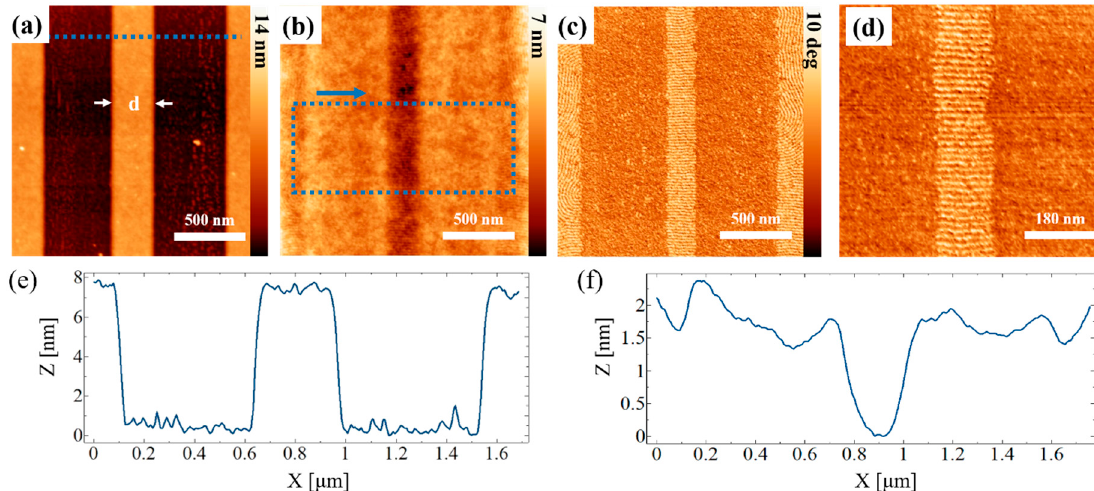
Figure 2. Results of grain-boundary-induced alignment via atomic force microscopy (AFM) mechanical removal. ( a ) AFM height image of guiding pattern with two areas treated by AFM mechanical removal (m-AFM) without brush layer (corresponds to sketch 2.a in Figure 1); ( b ) AFM height image of directed self-assembly (DSA) on area depicted in ( a ); ( c ) AFM phase image taken simultaneously to image ( b ), showing the self-assembly in horizontal (wide stripes) and vertical (narrow stripes) lamellae ; ( d ) Zoom-in the central stripe of the AFM phase image of ( c ); ( e ) single line profile along blue dashed line in ( a ); ( f ) average height profile (i.e., average of all line scans) as indicated by the box in ( b ).